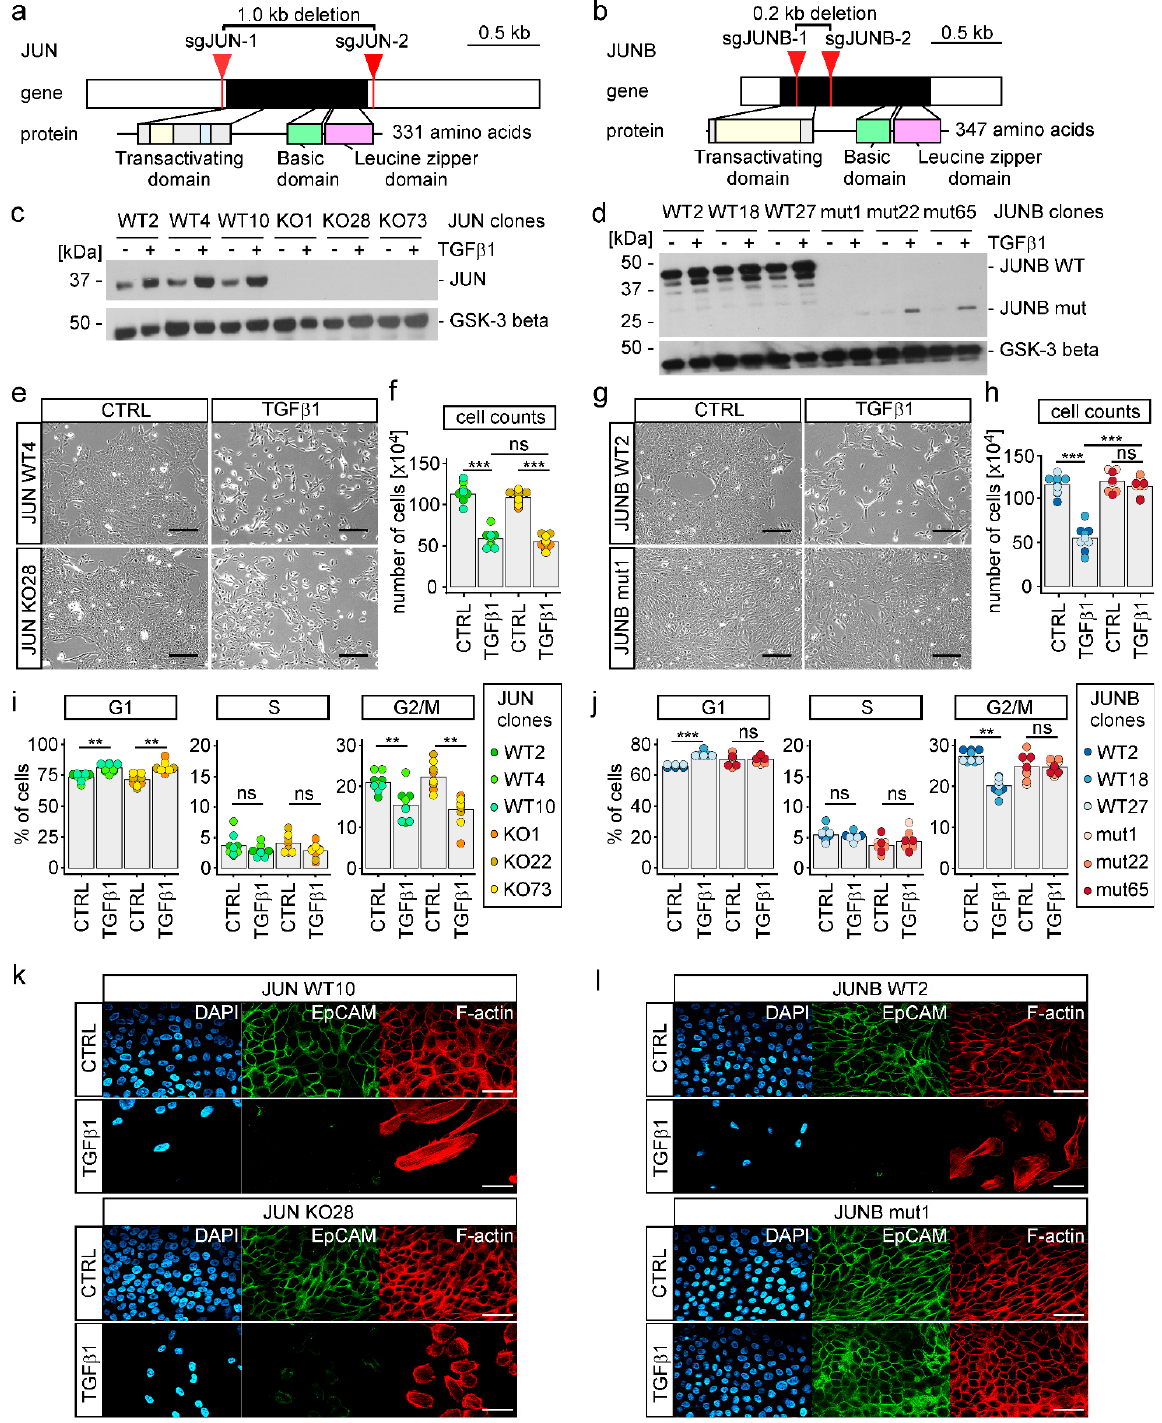
Figure 5. Inactivation of JUNB impairs TGF β 1-induced morphological changes and cell cycle progression of MCF10A cells. ( a , b ) Schematic representation of the human JUN and JUNB genes and proteins. Exons are depicted as boxes with protein-coding parts colored in black and UTRs in white. Relevant functional domains of the proteins are indicated by color and linked to the exonic region by which they are encoded. The locations of sgRNA targets used for inactivation of JUN and JUNB are marked by red arrows. ( c , d ) Detection of JUN and JUNB by Western blot using nuclear extracts from MCF10A wild type (WT) and knock-out (KO) or mutant (mut) cell clones. One representative result from three independent biological replicates is shown. Uncropped versions of immunoblots